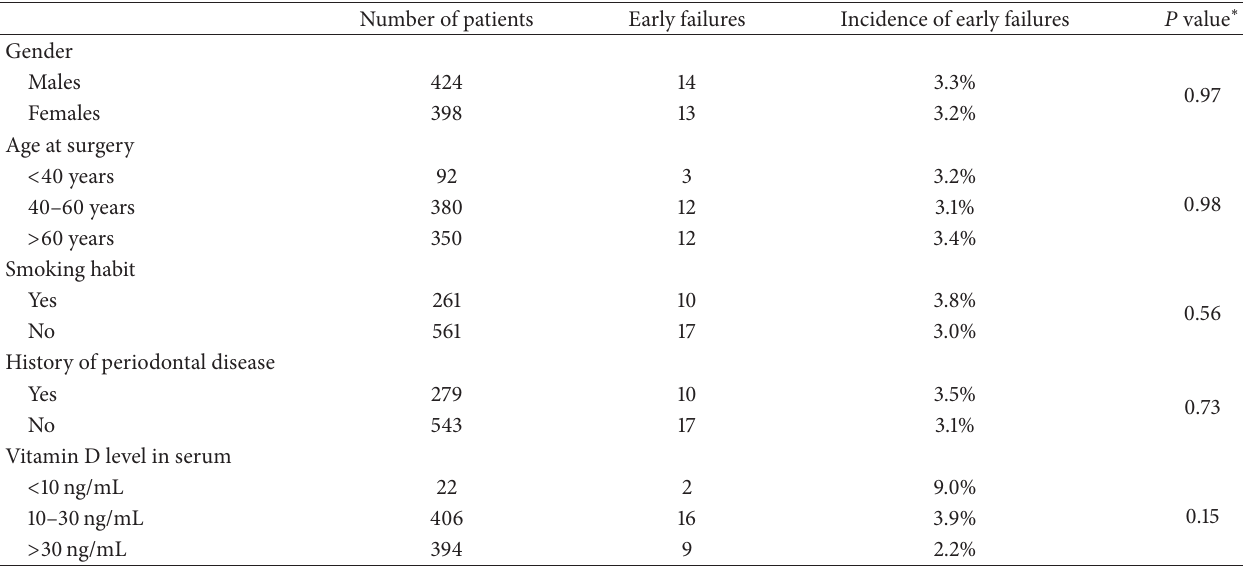
Table 1: Distribution of patients (by gender, age at surgery, smoking habit, history of periodontal disease, and vitamin D levels in serum), related failures, survival rate within groups, and differences between groups (Chi square